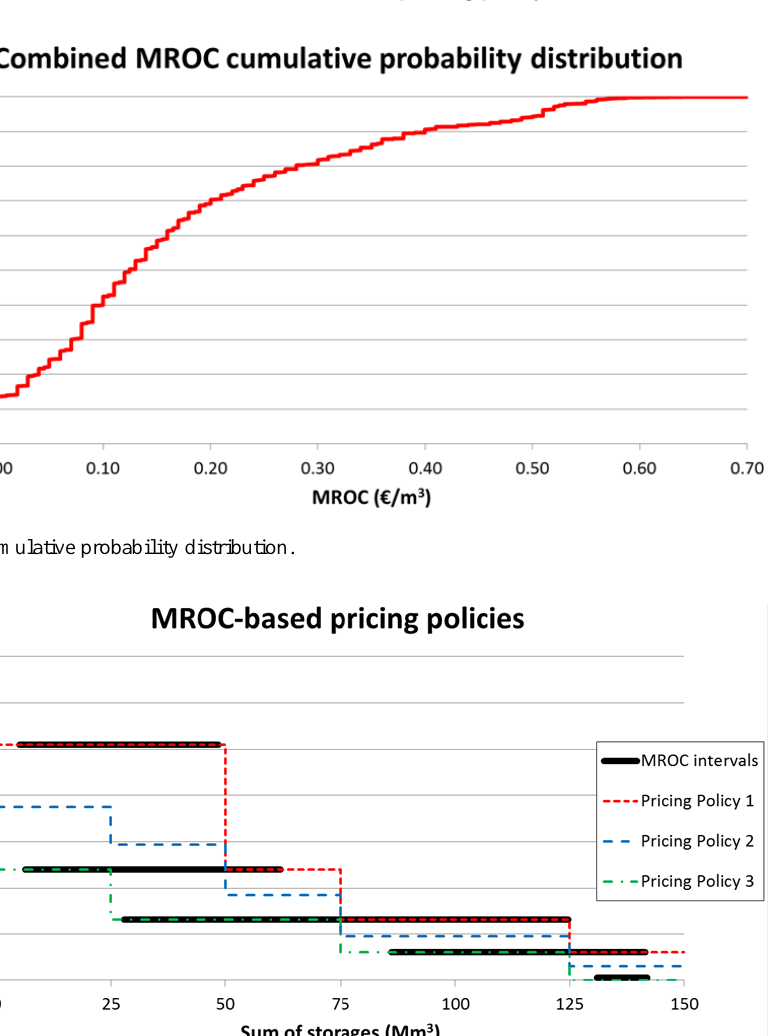
Figure 7. MROC-based pricing policies.